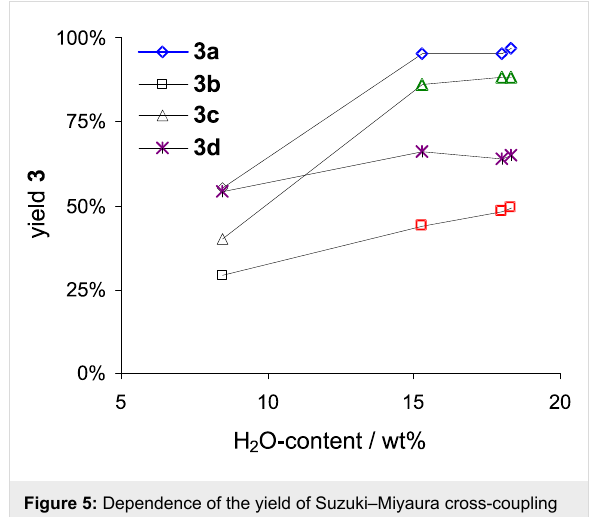
Figure 5: Dependence of the yield of Suzuki–Miyaura cross-coupling product (Scheme 1) from water content (Karl-Fischer titration) of ( d = 15 mm) per beaker, 800 rpm, 10 min; batch: 5 mmol aryl bromide, 124 mol % phenylboronic acid, 3.6 mol % Pd(OAc) 2